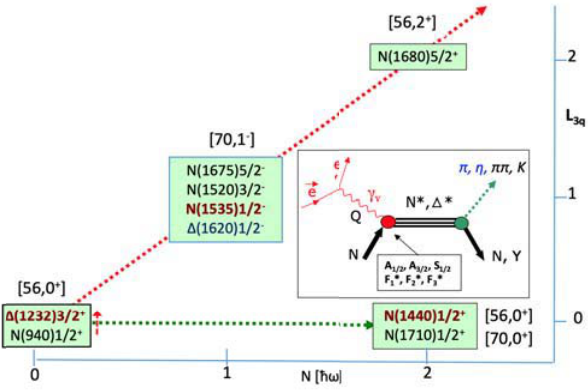
Fig. 12 Schematics of SU (6) ⊗ O (3) supermultiplets with some of the excited states that have been explored in ep → e (cid:3) π + n , ep → e (cid:3) pπ ◦ , ep → e (cid:3) pη , and ep → e (cid:3) pπ + π − electro- production experiments. The inset shows the helicity ampli- tudes and electromagnetic multipoles often used to describe the data. Only the states highlighted in red are discussed